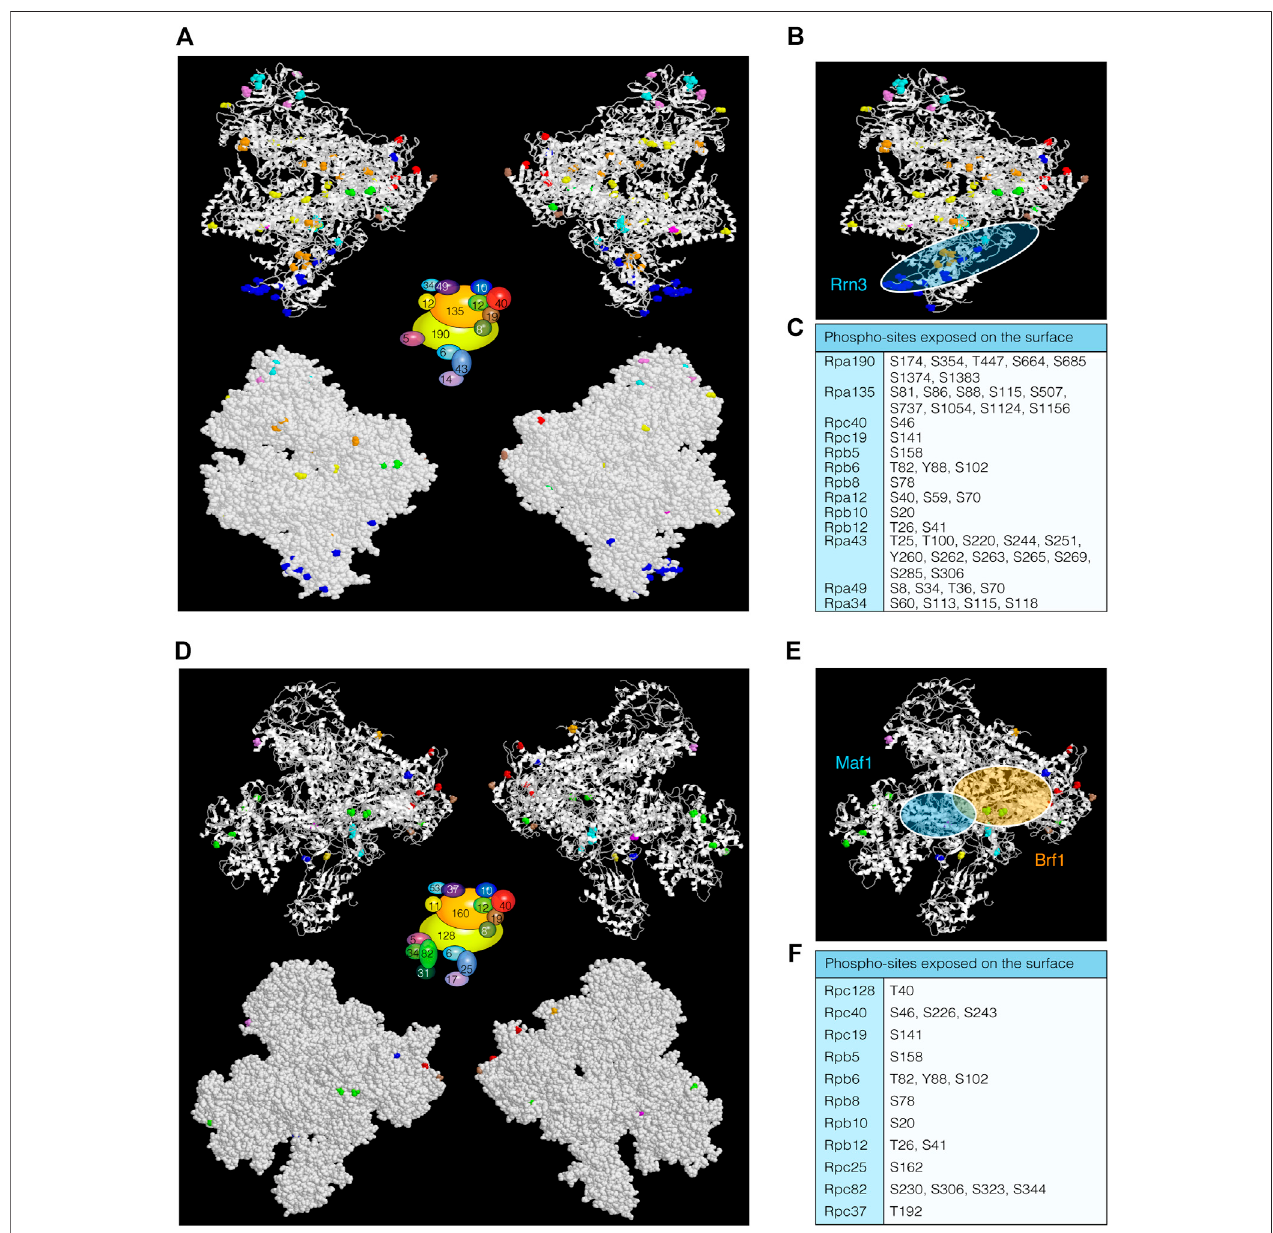
FIGURE2| RNAPIandRNAPIIIphospho-sites. (A) Ribbon ( upper ) andsurface ( bottom ) schematicviewsofRNAPI(PDB:4c3h)from Saccharomycescerevisiae , displaying phospho-sites labelled in different colours according to the subunit diagram shown in the middle of the fi gures. (B) Schematic representation of Rrn3 localization (Torreira et al., 2017). (C) Table with phospho-sites exposed on the surface of RNAPI. (D) Ribbon ( upper ) and surface ( bottom ) representations of RNAPIII (PDB: 5fj9) displaying coloured phospho-sites. (E) Schematic representation of Maf1 and Brf1 associations with RNAPIII (Vorlander et al., 2020a; Vorlander et al., 2020b). (F) Table with RNAPIII phospho-sites exposed on the surface. As in the case of RNAPII, these residues could be important for the interaction with transcription